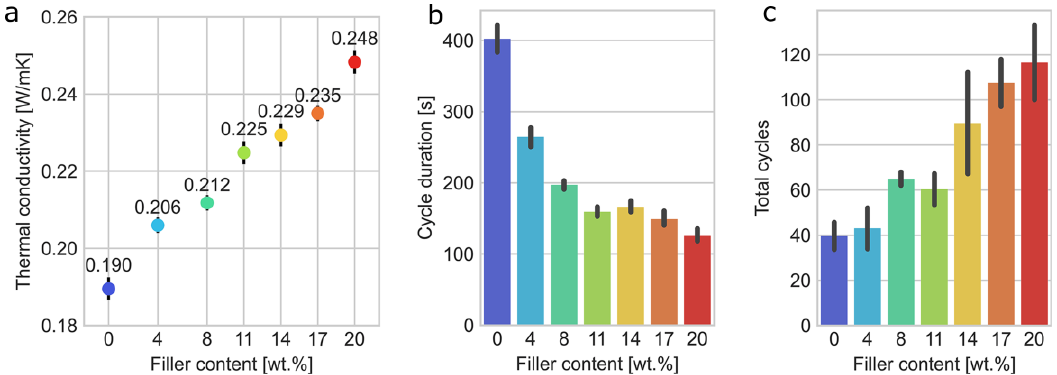
Figure 2. Effect of diamond nanoparticle-based filler on ( a ) thermal conductivity of silicone/ethanol material actuator, ( b ) actuation cycle duration for the first 30 cycles, ( c ) and maximal amount of cycles for the silicone/ethanol material-actuator.